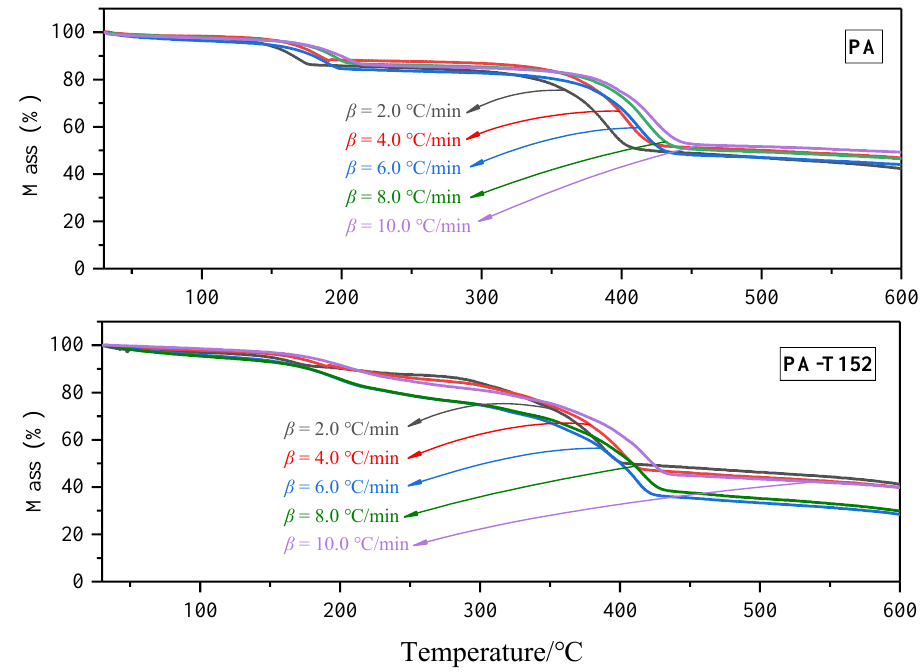
Figure 3. TG curves of PA and PA-T152 at different β .